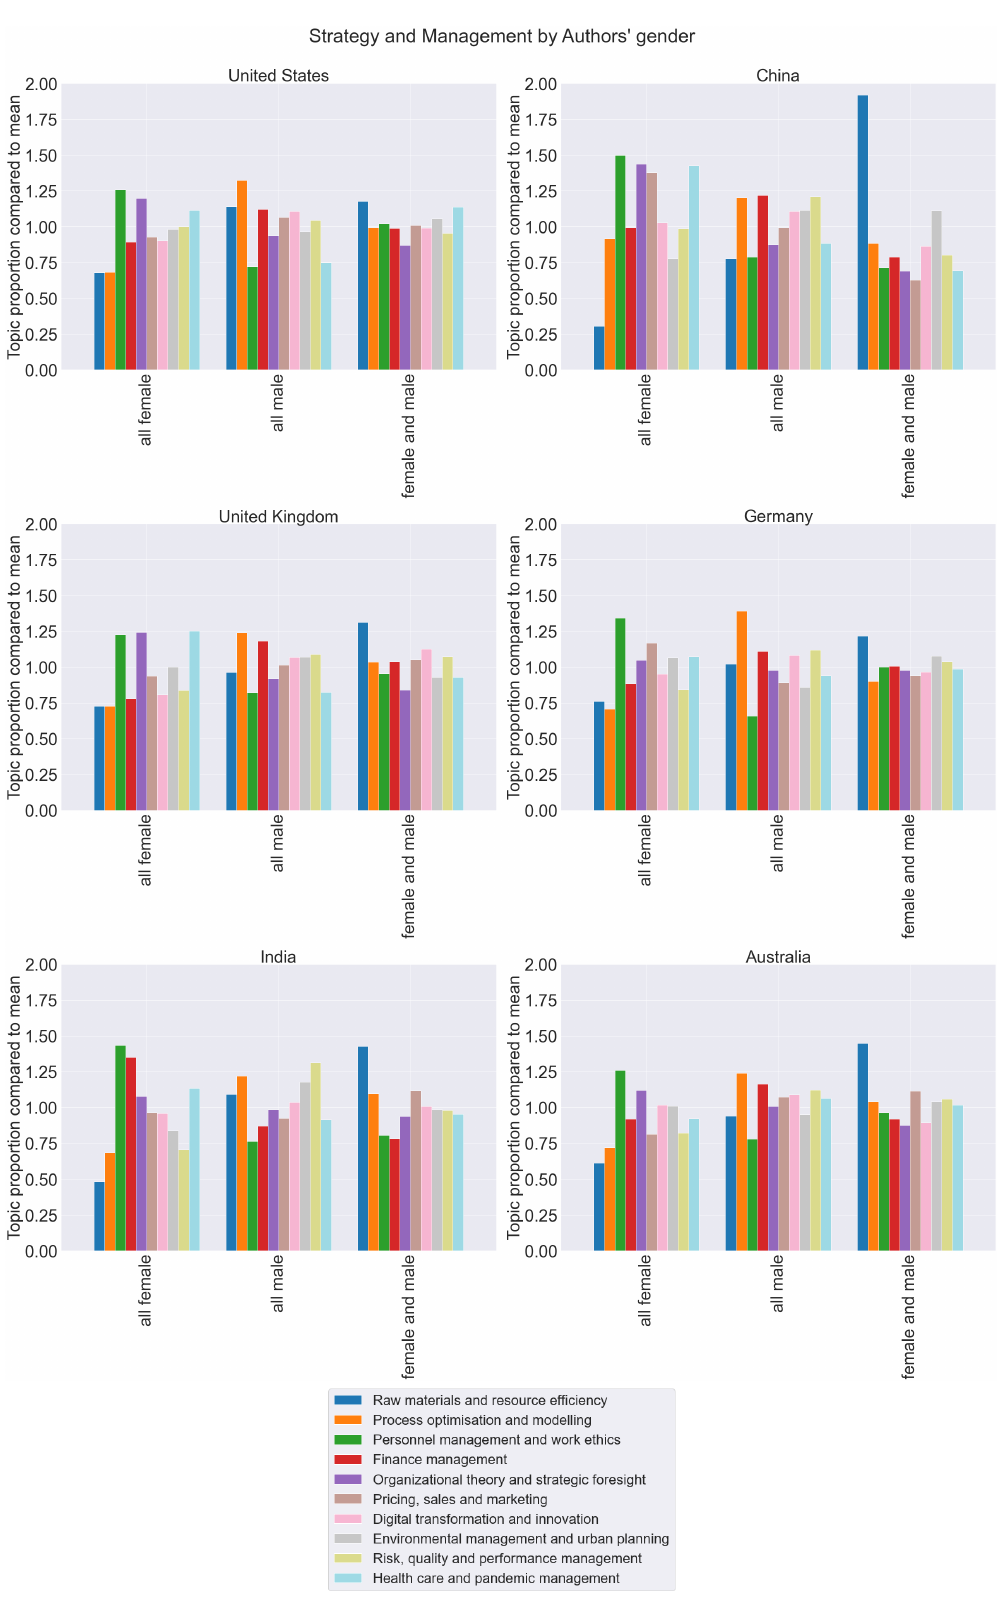
Figure 12. Topic proportion compared to mean, c κ ( ˆ D α ) , for 10 topics of the sub-area strategy and management grouped by authors’ gender for individual countries: US, China, UK, Germany, India, Australia (from top left to bottom